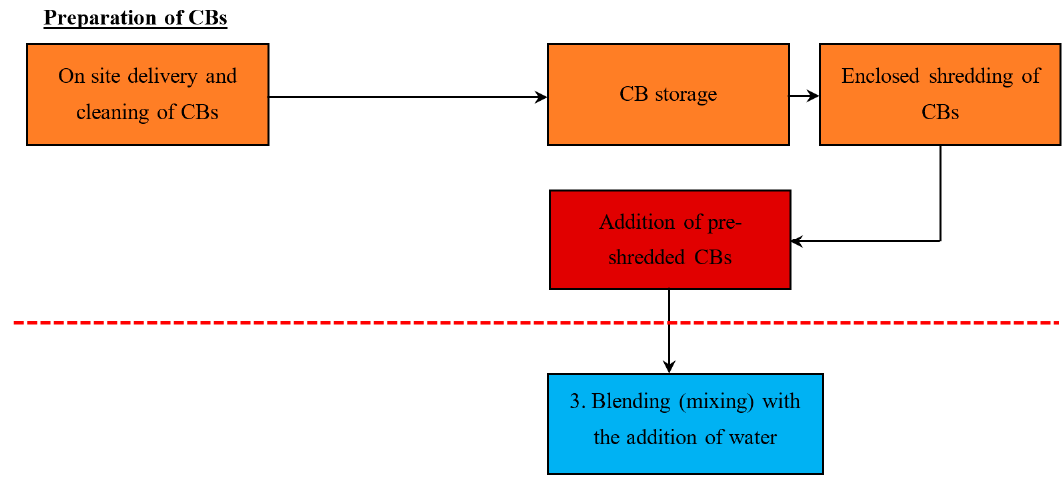
Figure 3. Method 2—Addition of pre-shredded CBs into the Automatic Manufacturing Process.